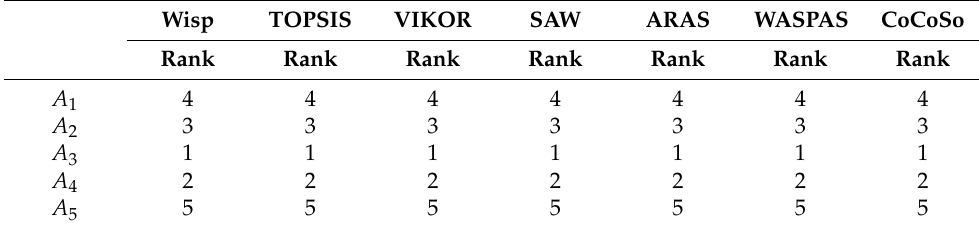
Table 23. Ranking orders obtained using selected MCDM